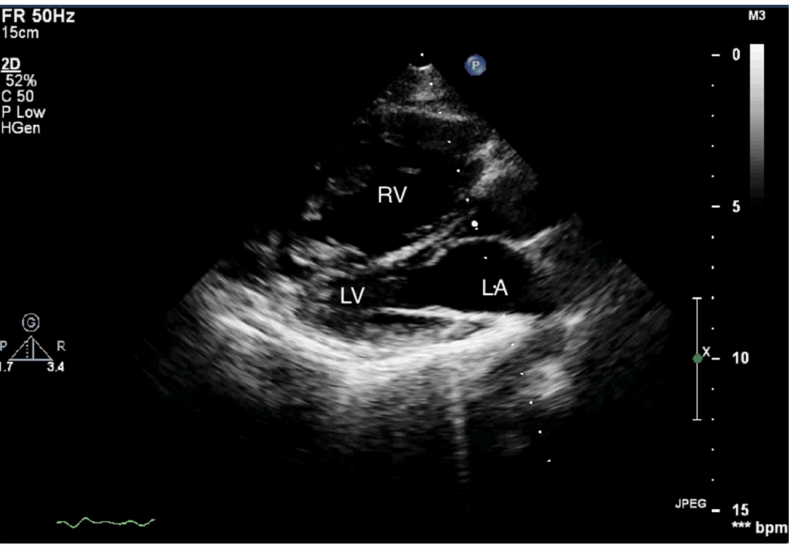
Figure 1. Enlarged right ventricle. Two-dimensional transthoracic echocardiography (2D-TTE), parasternal long-axis view (PLAX). RV: right ventricle, LV: left ventricle, LA: left atrium.